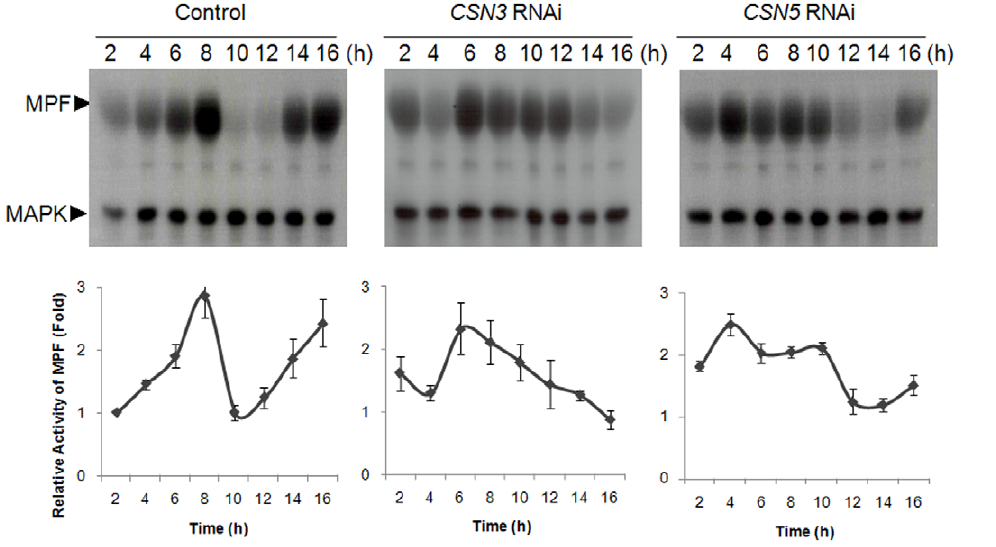
Figure 7. Dual kinase activity assay after CSN3 or CSN5 RNAi. MPF and MAPK activities were assessed by measuring the level of phosphorylation of Histone H1, a substrate of MPF, and myelin basic protein, a substrate of MAPK. Oocytes were collected every 2 h during in vitro maturation. Lower panel, relative MPF activity was determined by quantifying phosphorylation of substrates and was expressed relative to that of control oocyte at 2 h.